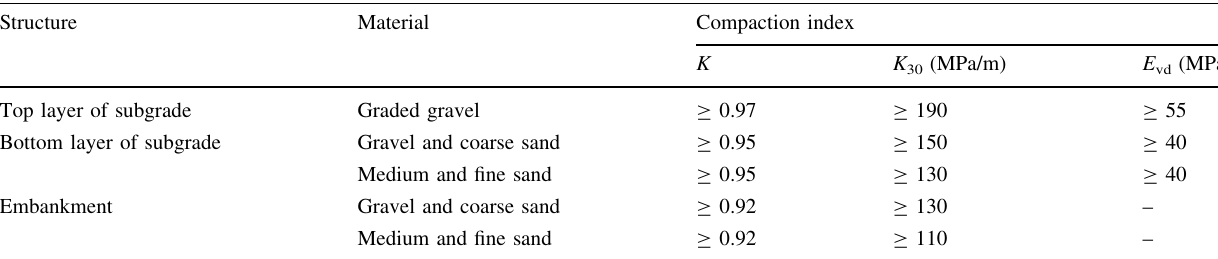
Table 2 Compaction indices of the subgrade and the embankment in the platform Structure